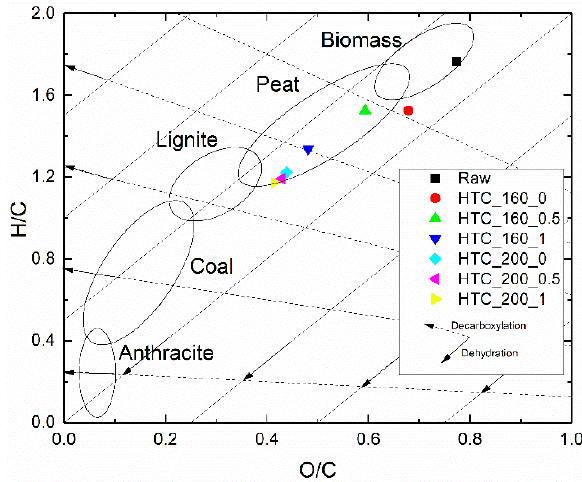
Figure 3. van Krevelen diagram of raw SPB and produced chars.